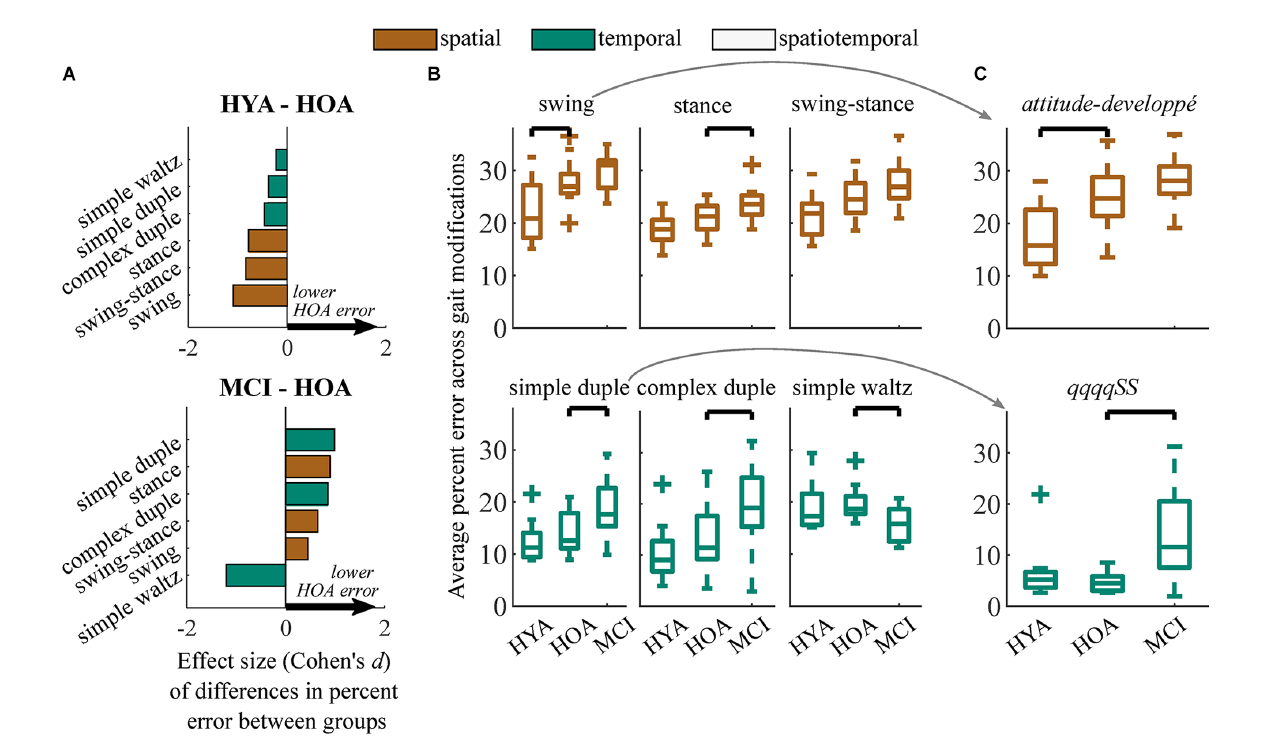
FIGURE4 (A) Effect sizes of differences in performance (Cohen’s d) between HYA and HOA groups (top) and HOA and MCI groups (bottom) in each gait modification subclass. Spatial and temporal modifications are denoted in orange and green, respectively. Positive values (arrows) imply that the HOA group exhibited lower error on gait modifications compared to either group. (B) Boxplots showing distributions of gait modification accuracy (percent error vs. targets) for spatial (top) and temporal (bottom) gait modifications. (C) Results from exemplary gait modifications that elicited the largest between-group effect sizes. The attitude-developpé modification (top) elicited the largest difference in spatial performance between the HYA and HOA groups. The simple duple modification, qqqqSS, elicited the largest difference in temporal performance between the HOA and MCI groups but did not differentiate between the HYA and HOA groups. We did not test for differences between the HYA and MCI groups.